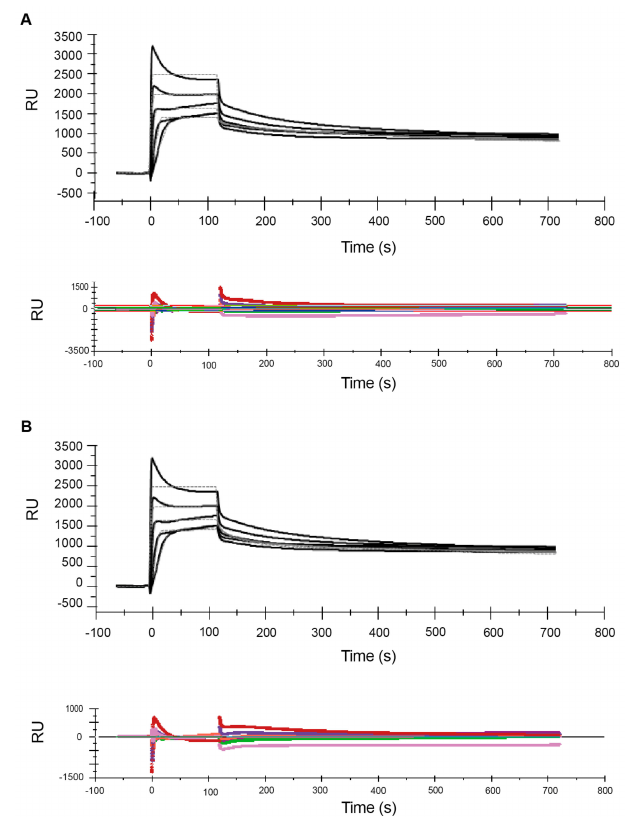
Figure 4. Effect of sodium chloride on the association phase of the melittin–POPC interaction. Following immobilization of POPC liposomes (1 mM lipid), increasing concentrations of melittin (2, 4, 6, 8 and 10 µ M) were serially injected with intermittent regeneration cycles with 10 mM glycine–HCl (pH: 2.5) ( A —multi-cycle) and single regeneration using the same buffer at the end of all cycles ( B